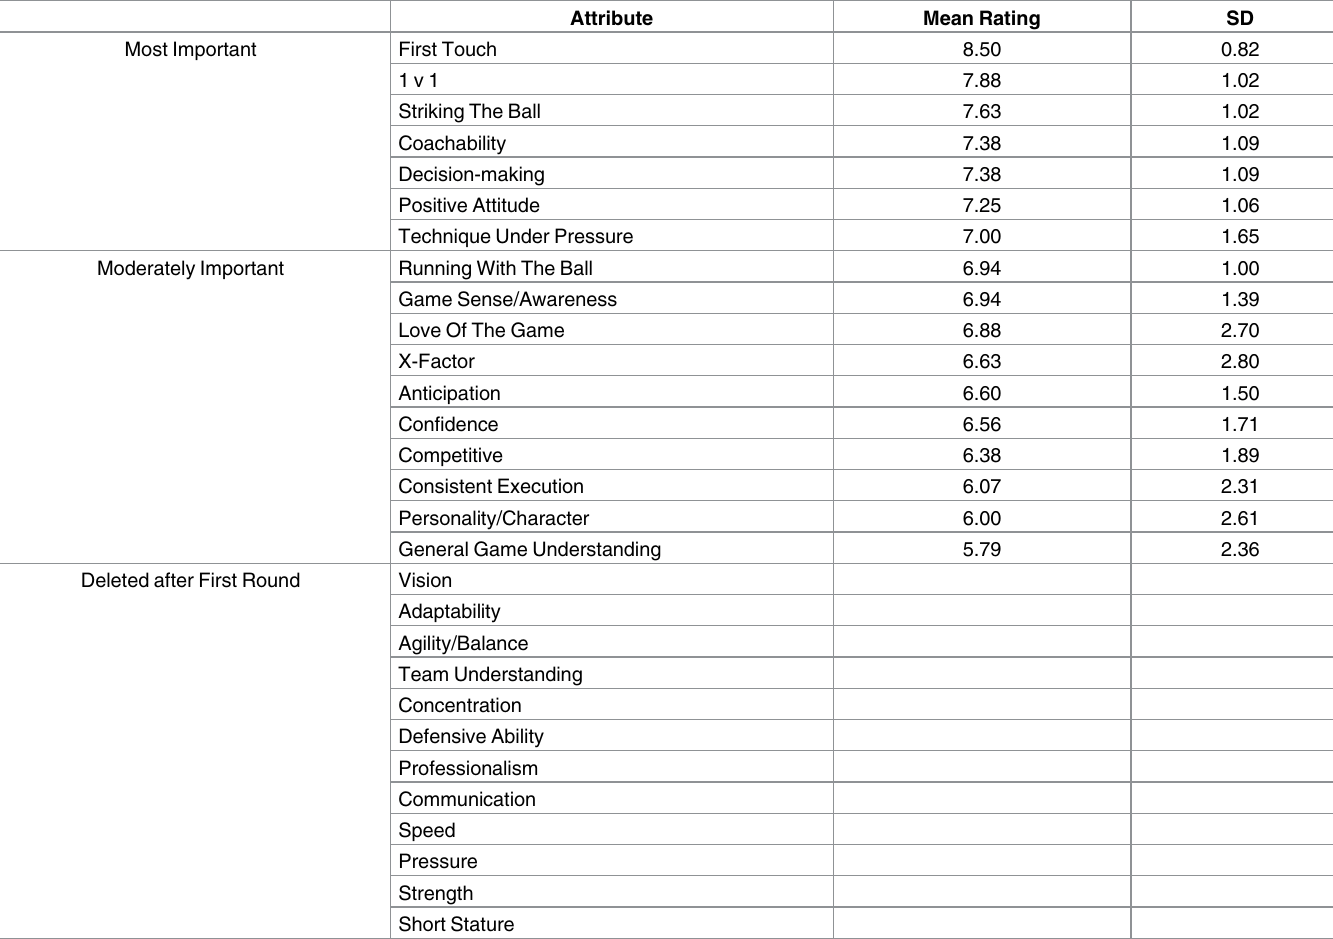
Table 2. Mean ratings and standard deviations of the attributes associated with elite soccer performance at the Under 13 level following the sec- ond round